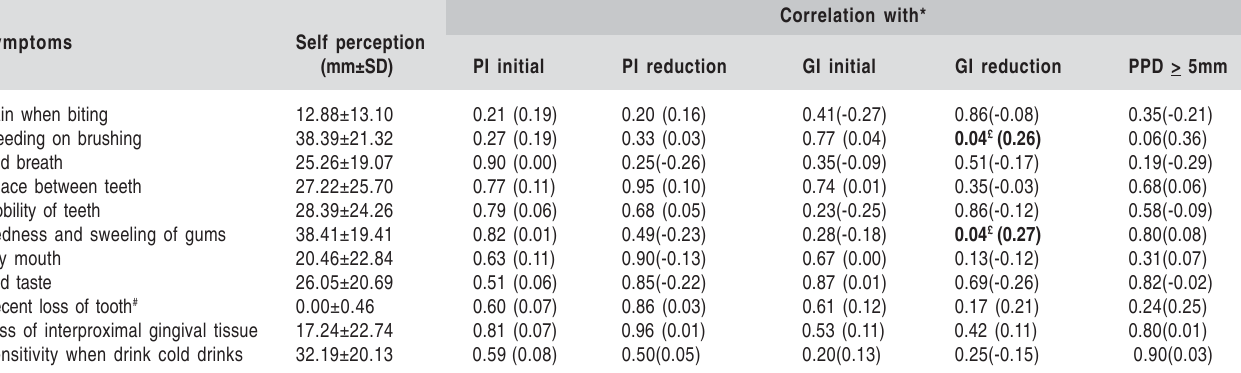
* p ( r value). # referred to modal